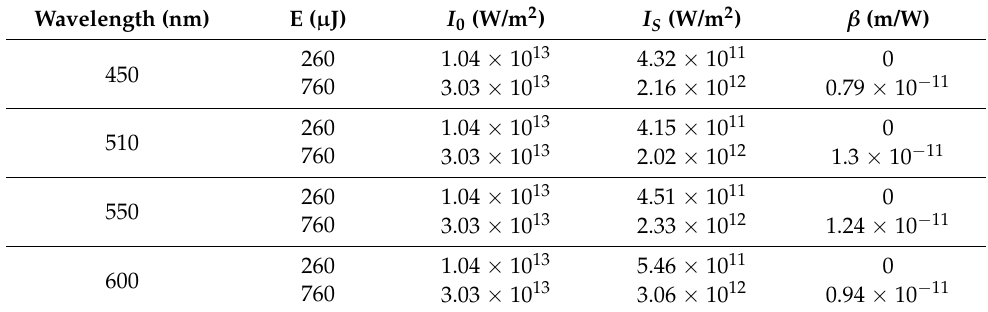
Table 1. Nonlinear optical parameters of the Au-Ag NPs.